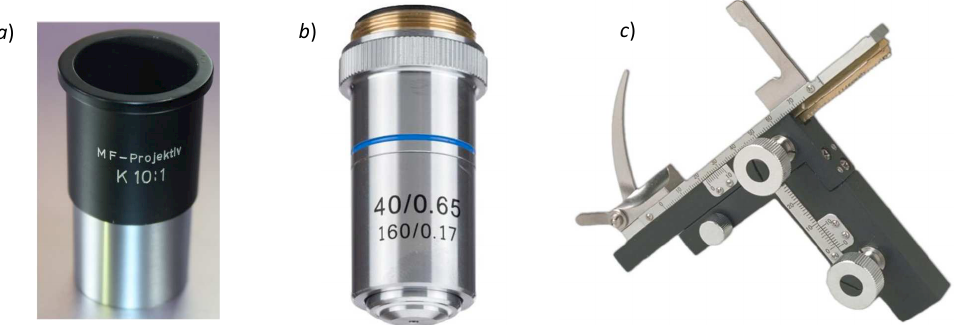
Figure 5. Optical and opto-mechanical components. ( a ) Optical ocular ZEISS MF-projektiv K 10 × , ( b ) achromatic objective lens OMAX with 40 × of magnification and 0.65 of numerical aperture (NA), and ( c ) OMAX X-Y microscope